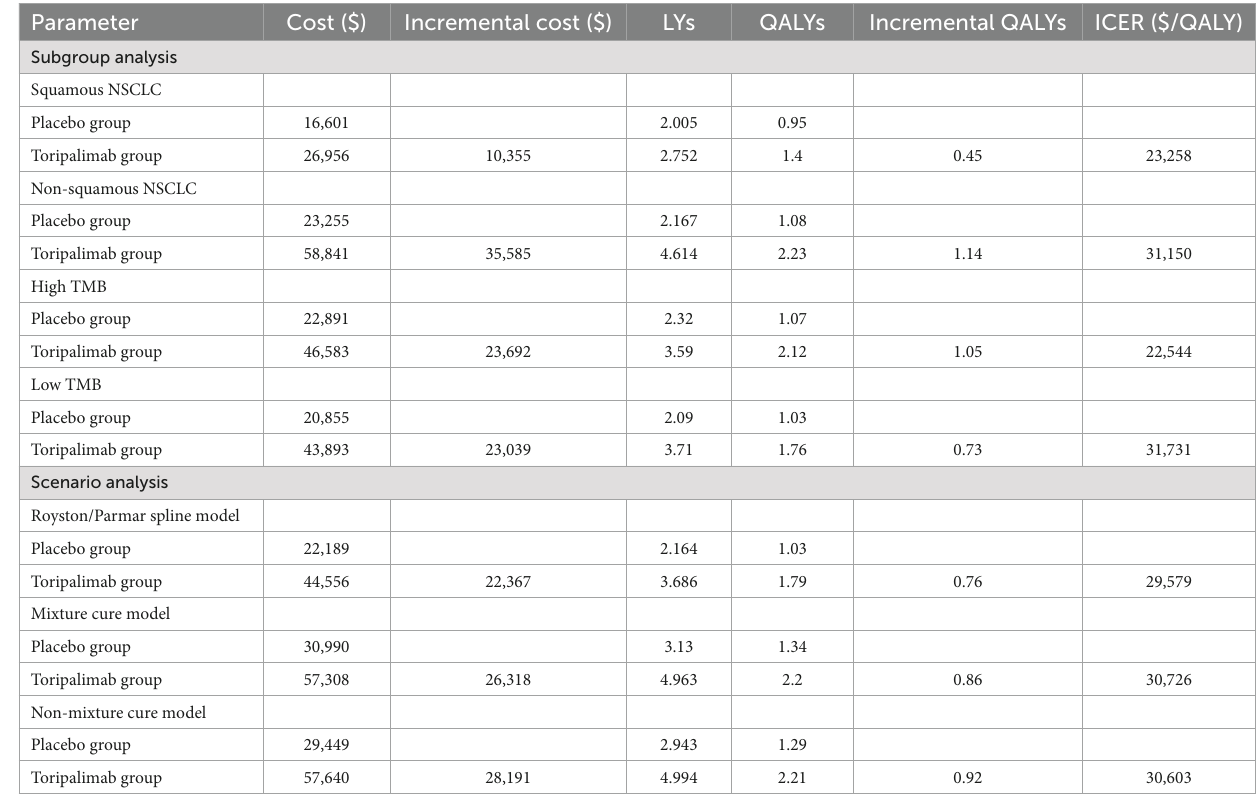
TABLE 3 Subgroup and scenario analysis results.